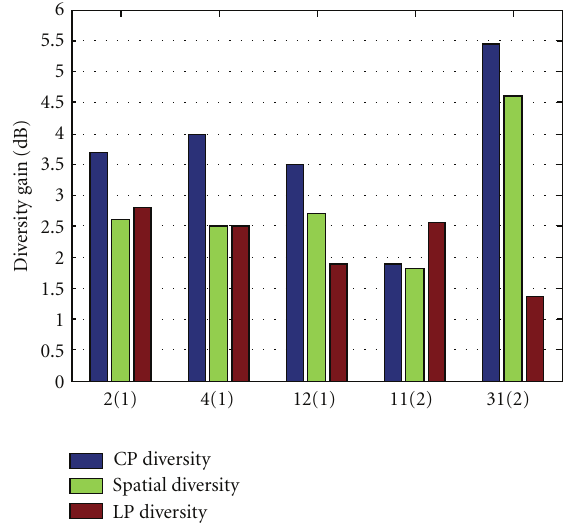
Figure 12: Diversity gain for various diversity